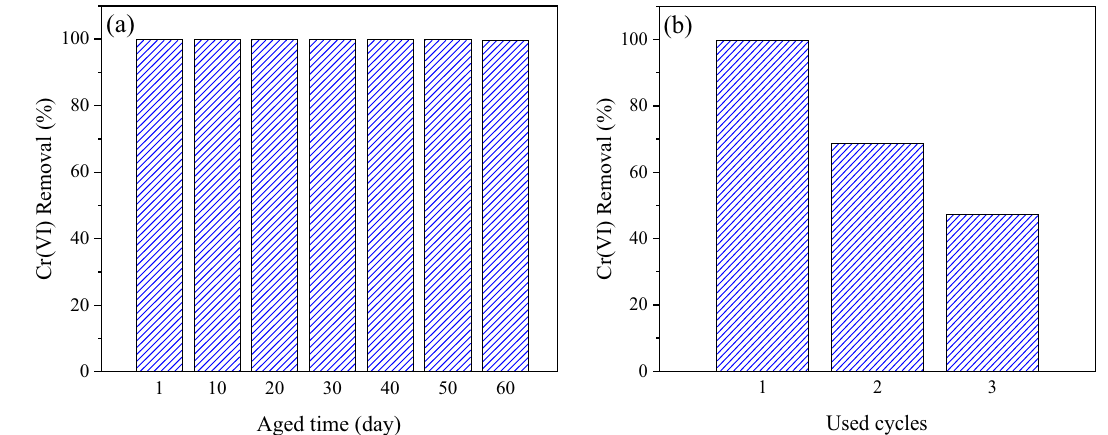
Figure 7. ( a ) Aging study and ( b ) reusability of Talc-nZVI/6Sn. Kinetic